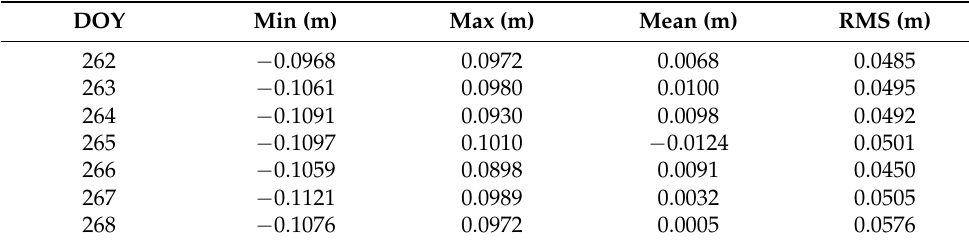
Table 5. Seven day SLR range validation residuals statistics.